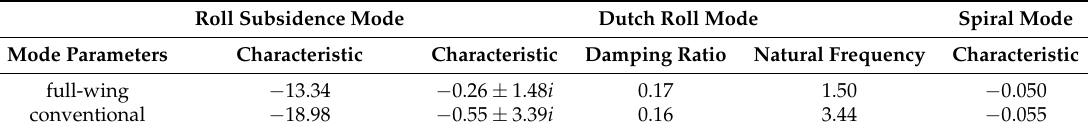
Table 2. The lateral-directional modes of full-wing and conventional configurations.